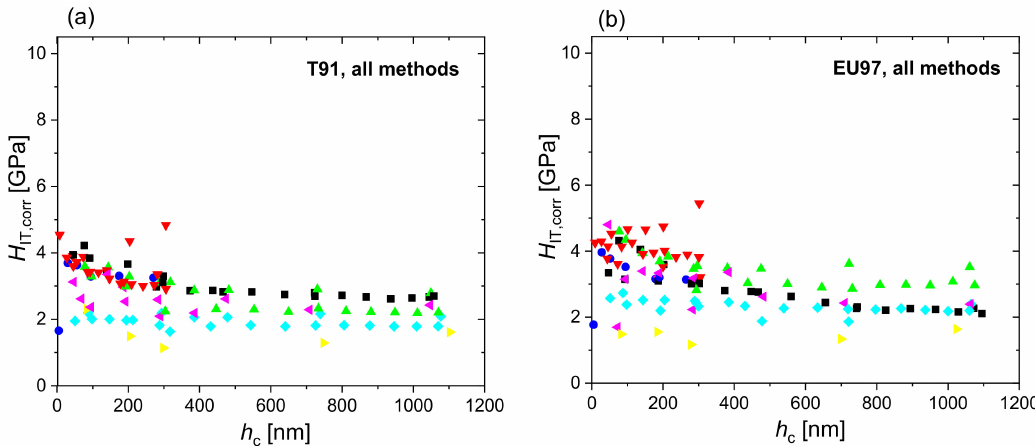
Figure 5. Indentation hardness corrected by the EMC factor, H IT,corr , of T91 ( a ) and Eurofer97 ( b ) for all methods combined (FSC, DSC and